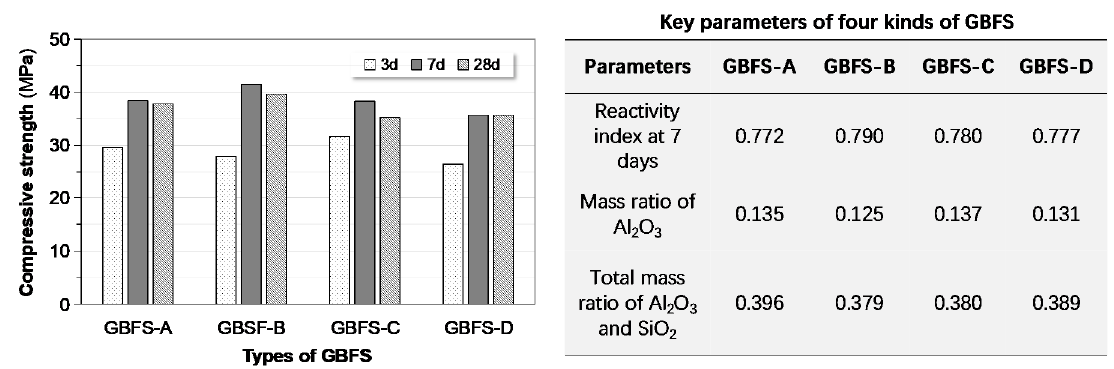
Figure 14. Correlating compressive strength to types of GBFS: several key parameters in terms of reactivity of GBFS are listed alongside.